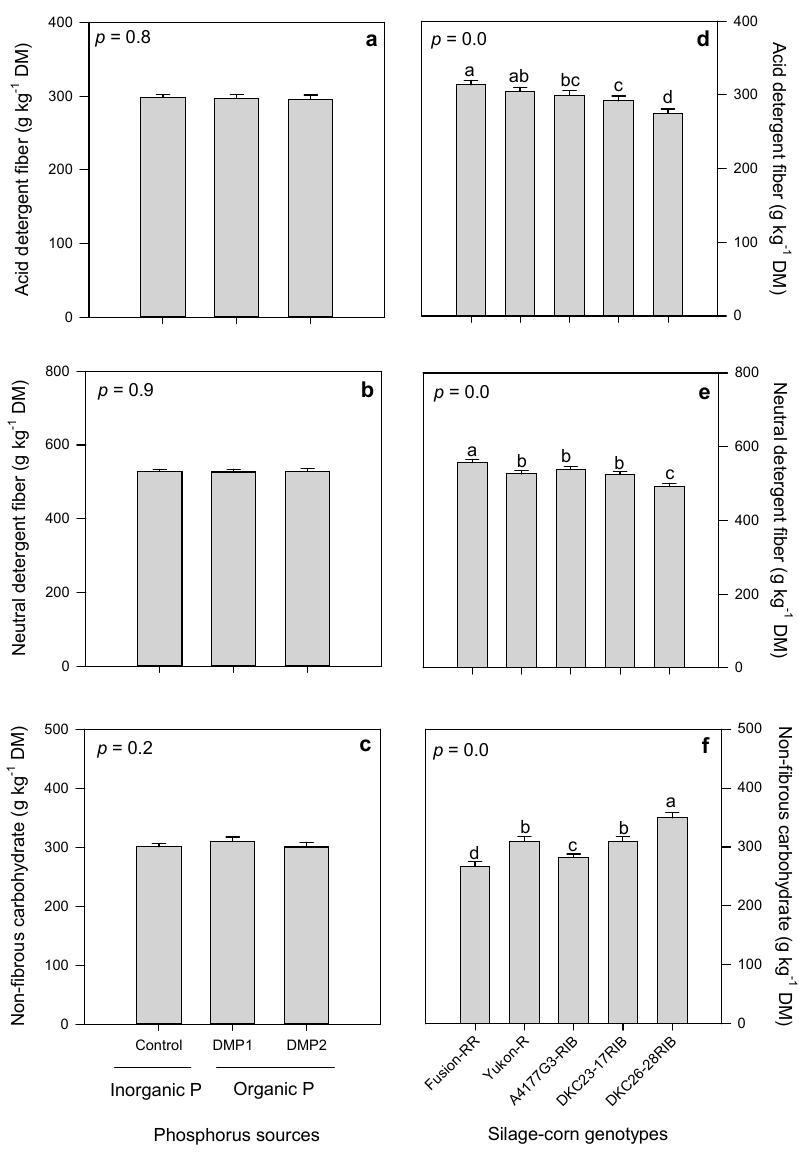
Figure 5. Effects of inorganic and organic phosphorus amendments on forage fibers: ( a ) acid detergent fiber (ADF), ( b ) neutral detergent fiber (NDF), and ( c ) non-fibrous carbohydrates (NFC). Variation in ADF ( d ), NDF ( e ), and NFC ( f ) among silage-corn genotypes. Each bar represents mean of three replications ± SE.